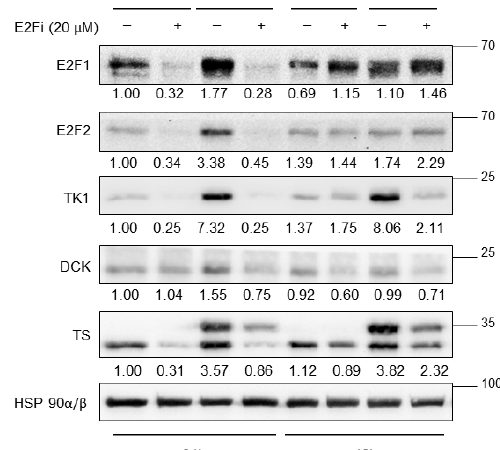
Figure 4. E2F inhibitor HLM (E2Fi) downregulates basal levels of E2F1, E2F2, TK1, DCK and TS ( TYMS ) and prevents 5-FU-induced upregulation. RT-QPCR analysis of E2F1 and E2F2 ( A ) and TK1 , DCK and TYMS ( B ) in PC3 cells 24 h after co-treatment with E2Fi (10, 20 µ M) and 5-FU (1, 5 µ M). L19 mRNA was used as normalization control. Results are expressed as fold-over samples treated with vehicle (mean ± SD) from 3 to 4 independent experiments. Statistical analysis was performed using ANOVA and Fisher’s test. *** p < 0.0001, ** p < 0.001, * p < 0.05. ( C ) Representative Western blot analysis of E2F1, E2F2, TK1, DCK and TS in extracts prepared from PC3 cells 24 or 48 h after co-treatment with E2Fi (20 µ M) and 5-FU (5 µ M). Expression of HSP90 was used as loading control. Numbers below the bands correspond to the relative densitometric values, expressed as fold-over vehicle 24 h sample. Similar results were obtained in at least 4 independent